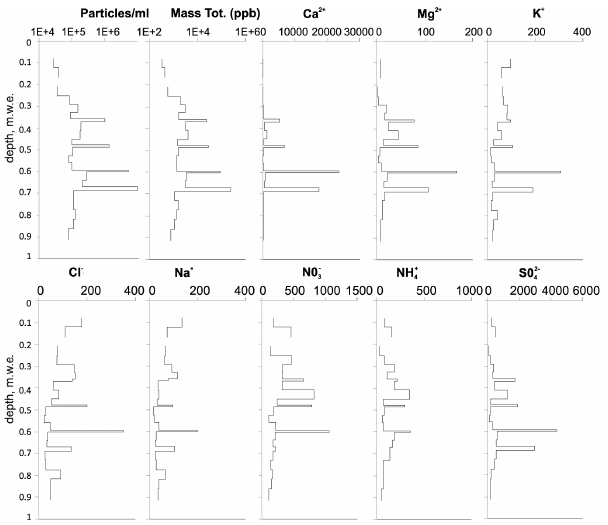
Fig. 11. Particle number, total mass, and major ion concentration recorded in the snow pit excavated in 2009. Ion concentrations are in